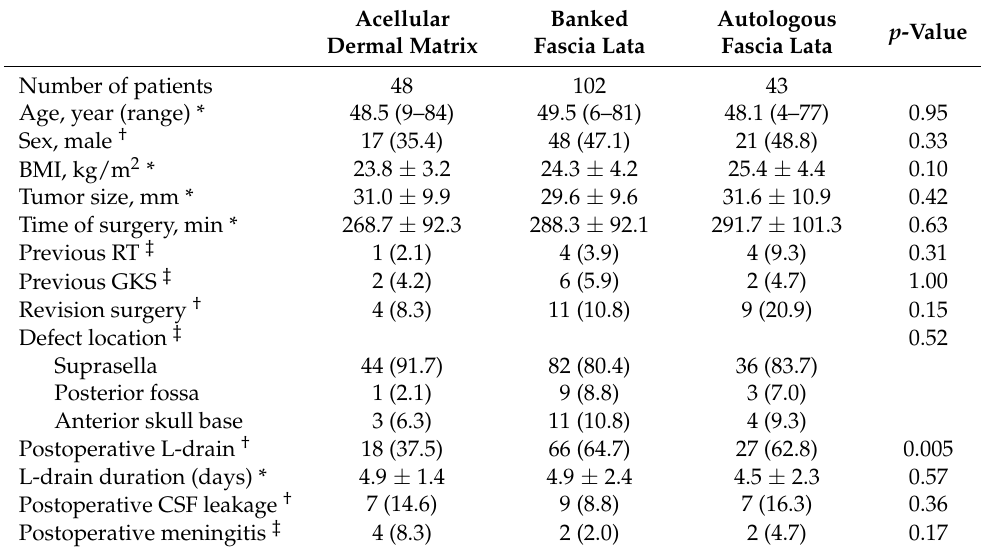
Table 2. Intergroup differences in various factors according to graft in dura reconstruction.